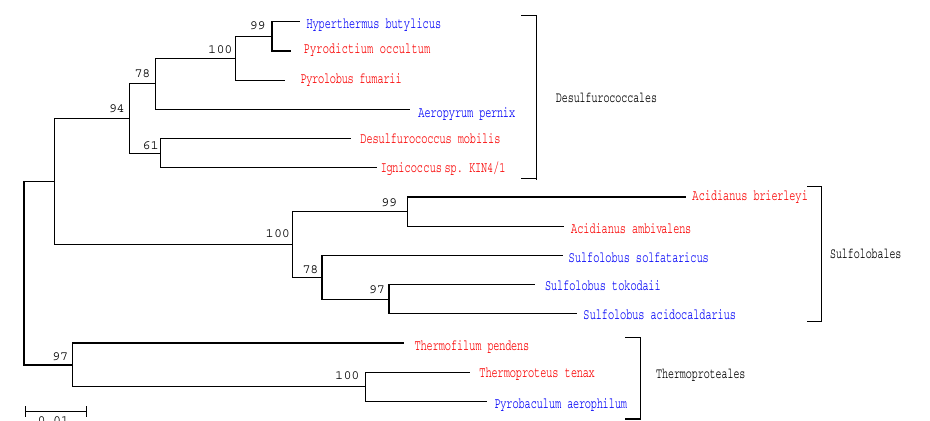
Figure 3. Phylogenetic tree based on 16S rRNA sequences gener-